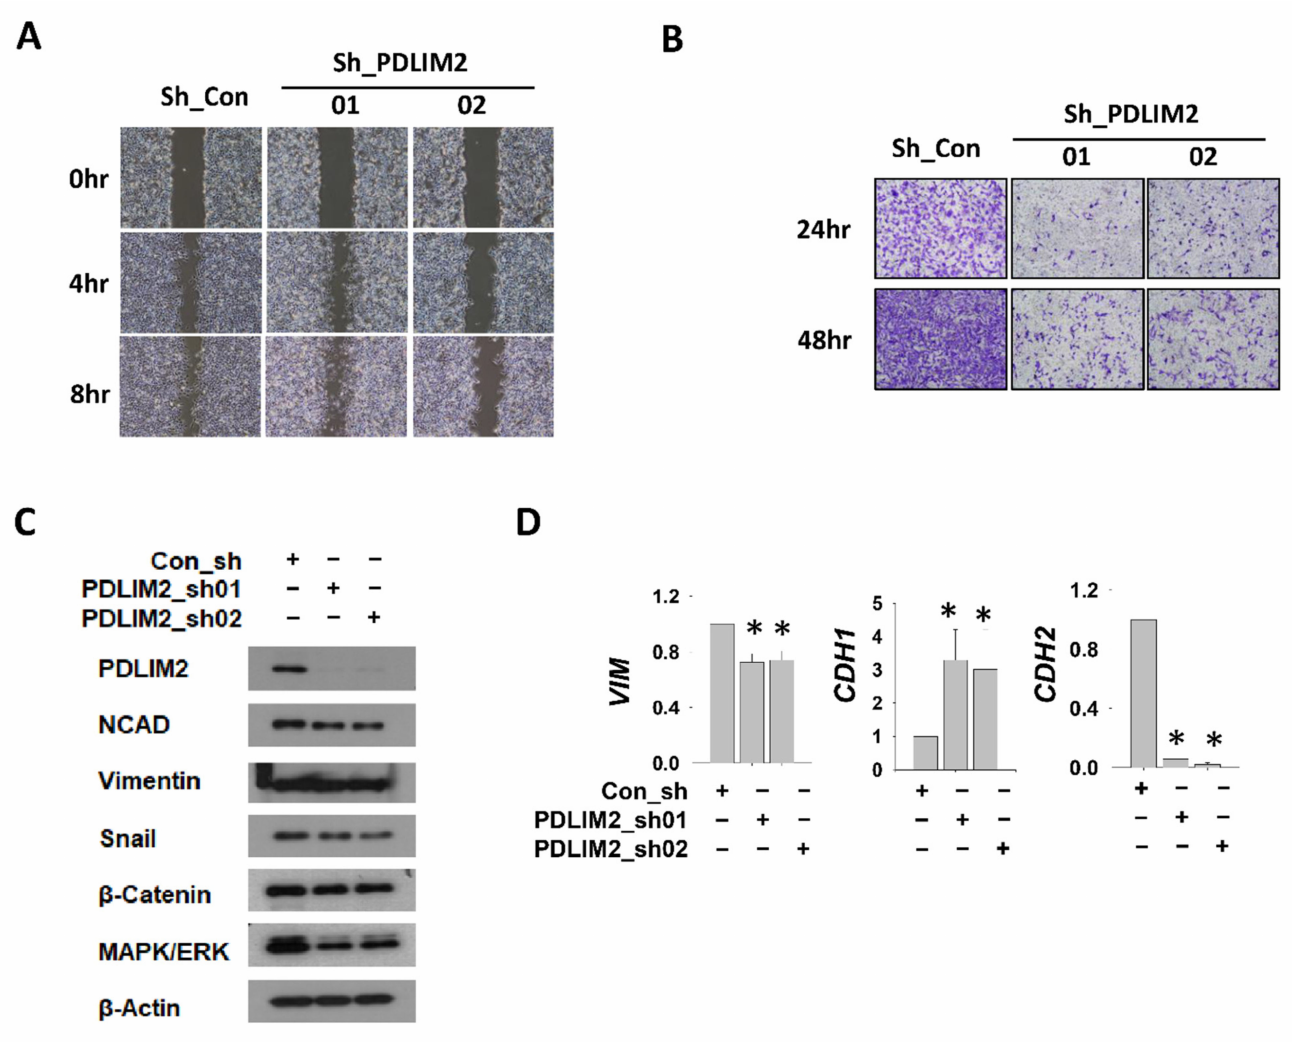
Figure 3. PDLIM2 knockdown reduced cell mobility and EMT-related gene expression in metastatic kidney cancer cell lines. ( A ) Cell migration after scratch-wounding control and PDLIM2 shRNA-expressing Caki-1 cells was observed after certain time points. ( B ) Transwell infiltration assay of stable cells with same cell numbers. At an indicated time point after plating, the cells that had migrated to the underside of the filters were fixed and stained with crystal violet, and photographs were captured. ( C ) The protein levels of the indicated EMT markers in the whole cell extracts of the control and PDLIM2 knockdown cells were measured. ( D ) The mRNA levels of indicated EMT marker genes in control Caki-1 cells and PDLIM2 knockdown Caki-1 cells were measured. Bars represent the mean ± standard deviation (SD) from three independent experiments, and * denotes p < 0.05 (Student’s t -test) versus the sh-con